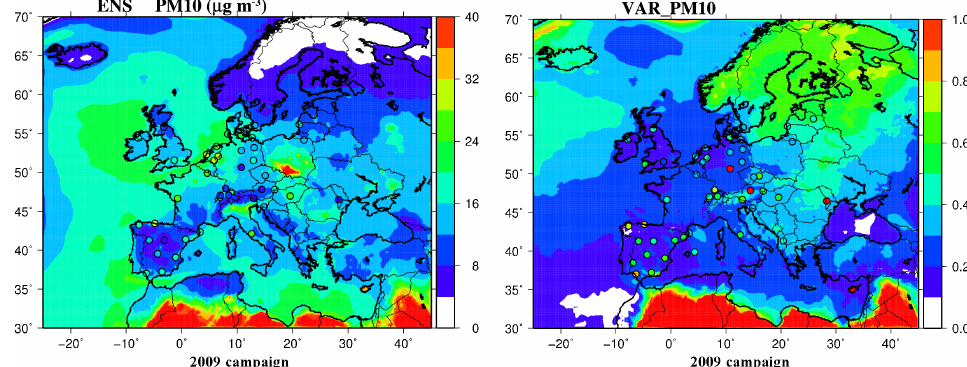
Figure 12. Left column: Mean PM 10 concentrations (µgm − 3 ) of the ensemble (ENS) for the 2009 campaign with corresponding observations (coloured dots). Right column: coefficient of variation of models (no unit) constituting the ensemble with corresponding normalized root mean square errors of the ensemble (coloured dots). Red colour is assigned for values exceeding the colour